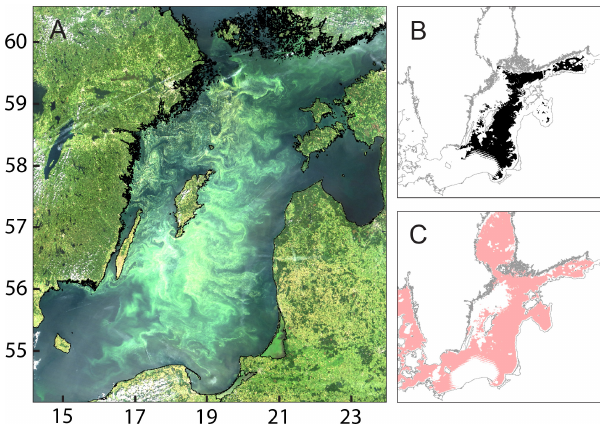
Figure 4. Example of cyanobacteria detection on AVHRR imagery of central Baltic Sea on 10 July 2005. (A) Grayscale image of band 1 albedo (bright tones correspond to higher albedo, dark tones to lower albedo). (B) Detected cyanobacteria accumulations (black). (C) Valid ocean areas (blue).